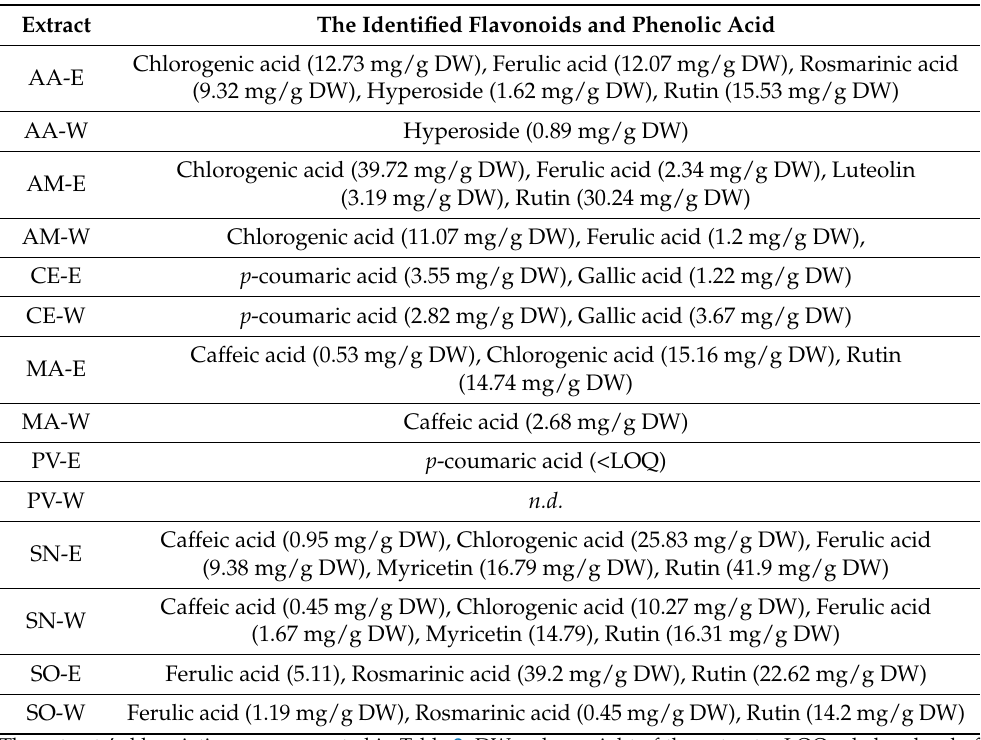
Table 5. Quantity of individual phenolic acids and flavonoids in the extracts. Extract The Identified Flavonoids and Phenolic Acid